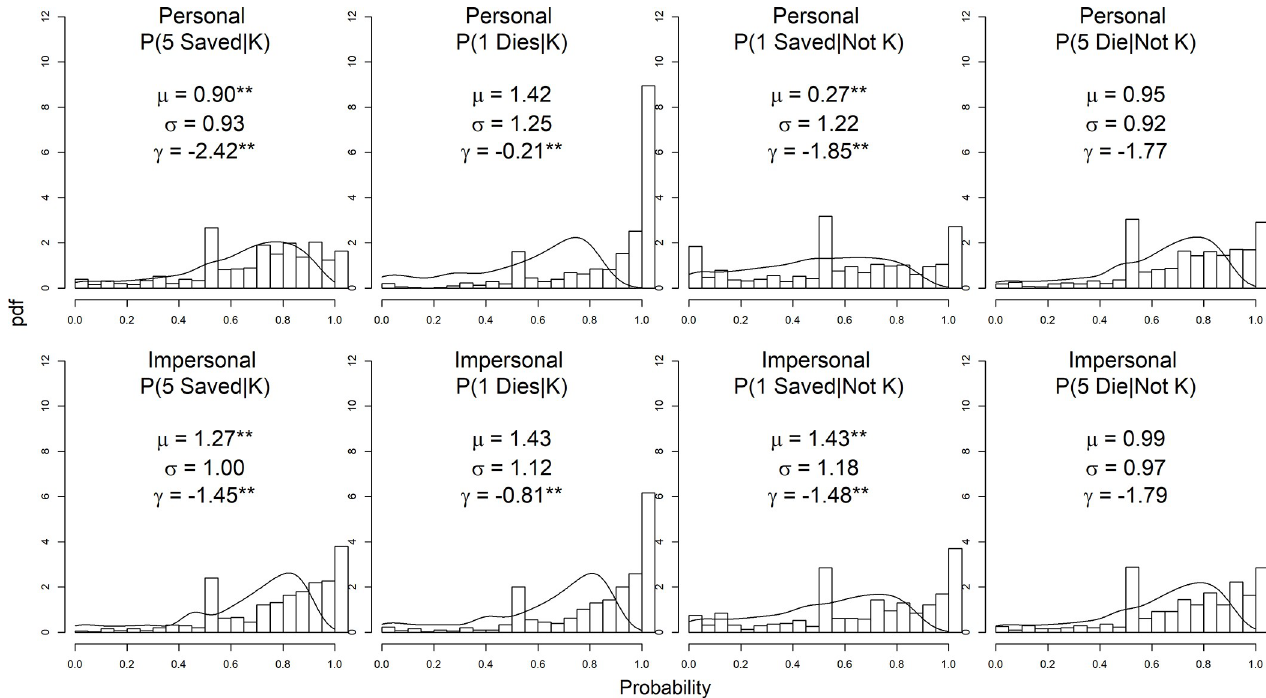
Fig 1. Histogram of the probability judgments across different probability types and dilemma types, and fitting results of the one-inflated T2-logistic models. The solid lines are fitted T2-logistic distribution curves. �� p < .001.